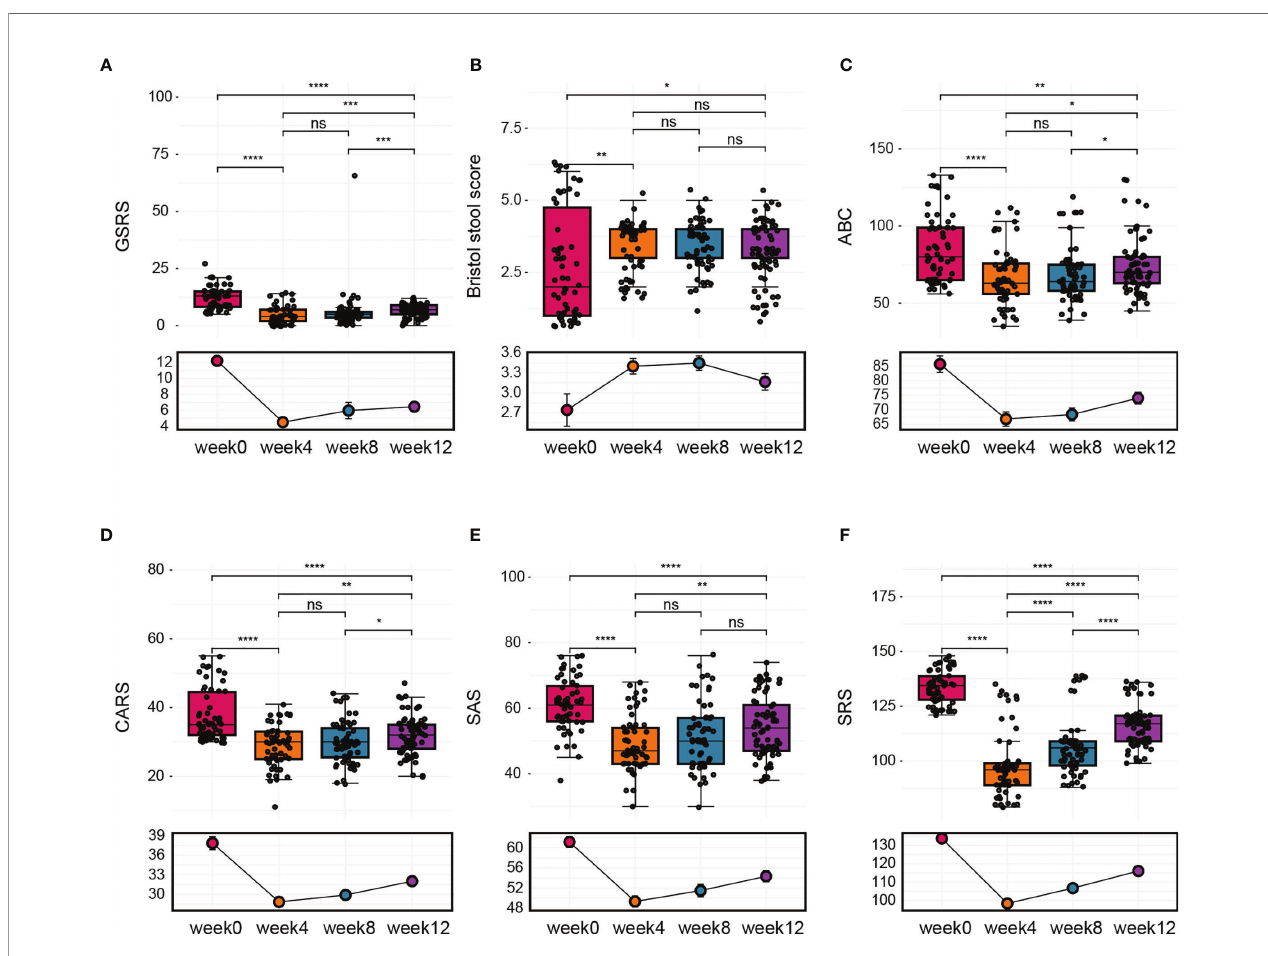
FIGURE 2 | The change in GI symptoms and ASD symptoms after FMT. Children were treated with FMT for 4 weeks and underwent follow-up evaluation for 8 weeks after treatment ended. (A) Changes in average GSRS scores after FMT. (B) Bristol stool scores. (C) Results of ABC assessment at different time points. (D) CARS scores before treatment, after treatment, and 8 weeks after treatment. (E) Total SAS scores before treatment, after treatment, and 8 weeks after treatment. (F) Total SRS scores before treatment, after treatment, and 8 weeks after treatment. The two-tailed Wilcoxon signed-rank test was used to determine the